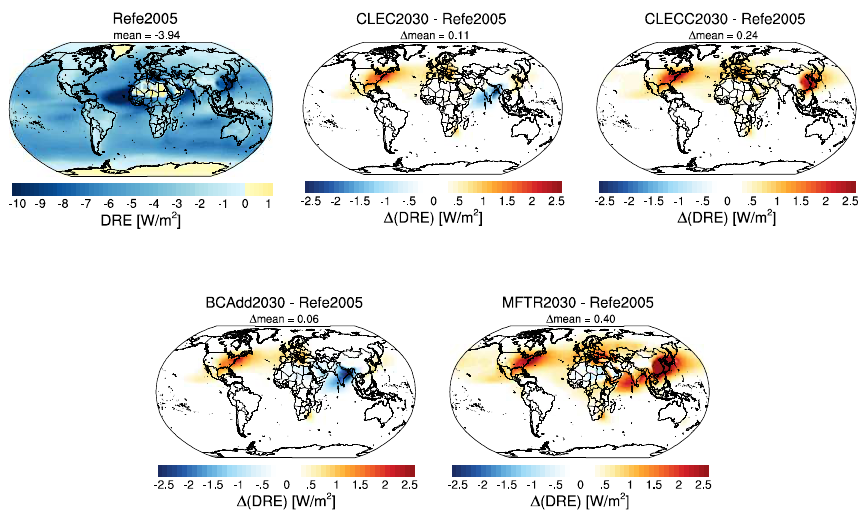
Figure 5. The yearly mean clear-sky direct radiative effect (DRE) at the top of the atmosphere in the reference run and the difference between scenarios and the reference